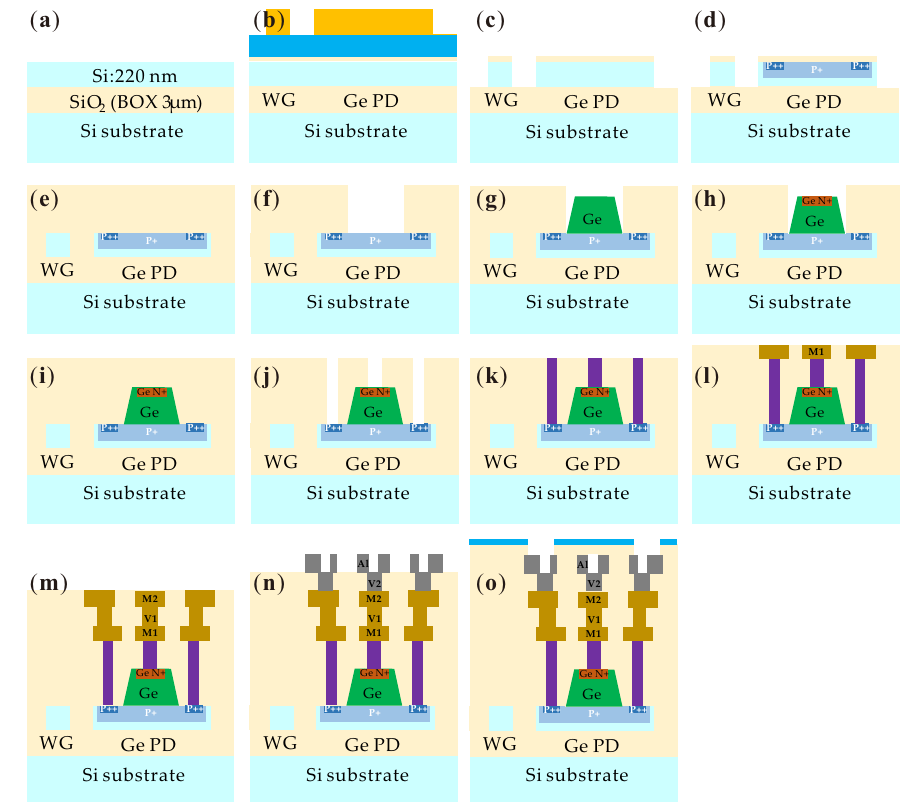
Figure 4. The schematic of the fabrication process flow for the waveguide and Ge PD. ( a ) Prepare the starting SOI wafer, which has a 2 µ m thick layer of BOX (Buried) on a Si substrate and a 220 nm thick layer of top silicon. ( b ) Si WG definition is performed by a nitride hard mask, which is deposited on top of the Si layer and patterned using lithography. ( c ) Si layer is etched and the hard mask is removed after resist stripping. ( d ) Base implants (P+, P++) are introduced on the Si layer for the photodetector. ( e ) Oxide filling and chemical mechanical polishing (CMP). ( f ) Ge PD windows opening. ( g ) The Ge layer is selectively grown by epitaxy. ( h ) N implant on Ge. ( i ) Oxide filling and CMP. ( j ) Opening windows for contacts on Si and Ge. ( k ) Tungsten (W) is filled and CMP is performed to format contact on both Si and Ge. ( l ) Metal 1 (M1) formation using the damascene process. ( m ) Via 1 (V1) and Metal 2 (M2) formation using the damascene process. ( n ) Via 2 (V2) and Pad aluminum (Al) are formed to provide electrical connections. ( o ) A nitride passivation layer is deposited to protect the device from external contaminants, and the passivation layer is then patterned using lithography to expose the necessary contact pads and openings for electrical